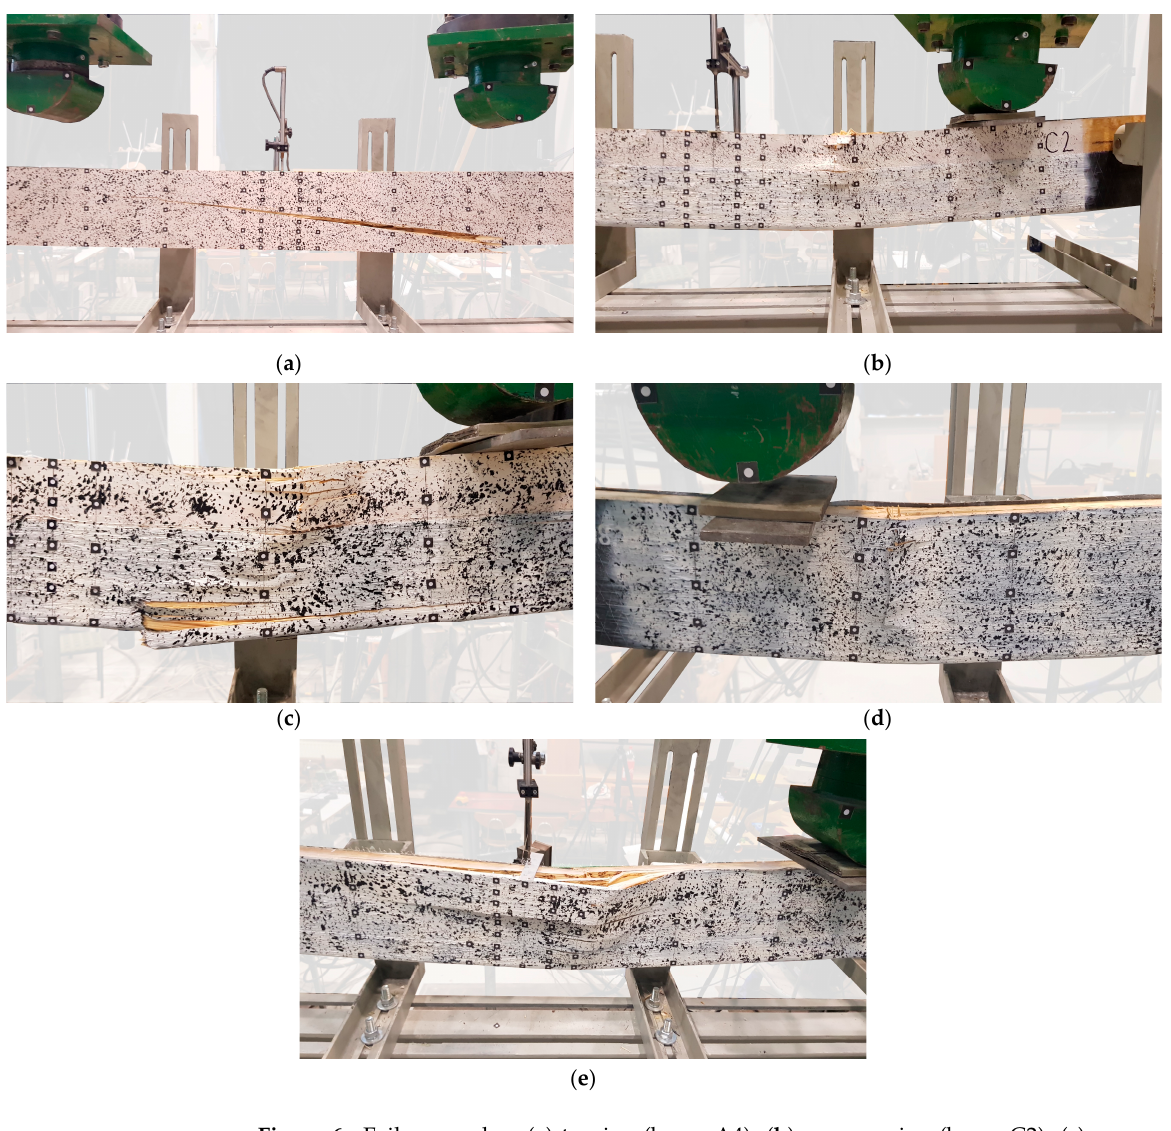
Figure 6. Failure modes: ( a ) tension (beam A4); ( b ) compression (beam C2); ( c ) compression + tension + rupture of CFRP sheet (beam B3); ( d ) shear of composite sheet + compression (beam D3); ( e ) compression + sheet delamination (beam D2).